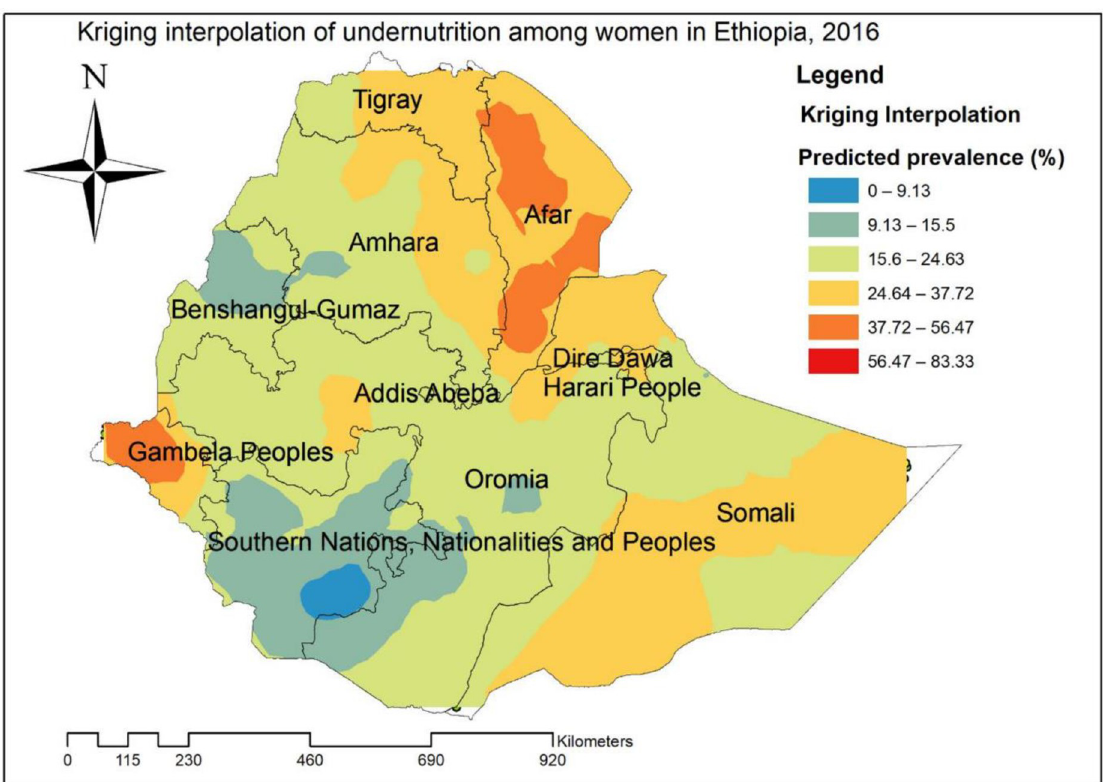
Fig 5. Kriging interpolation of undernutrition reproductive age women in Ethiopia, 2016.